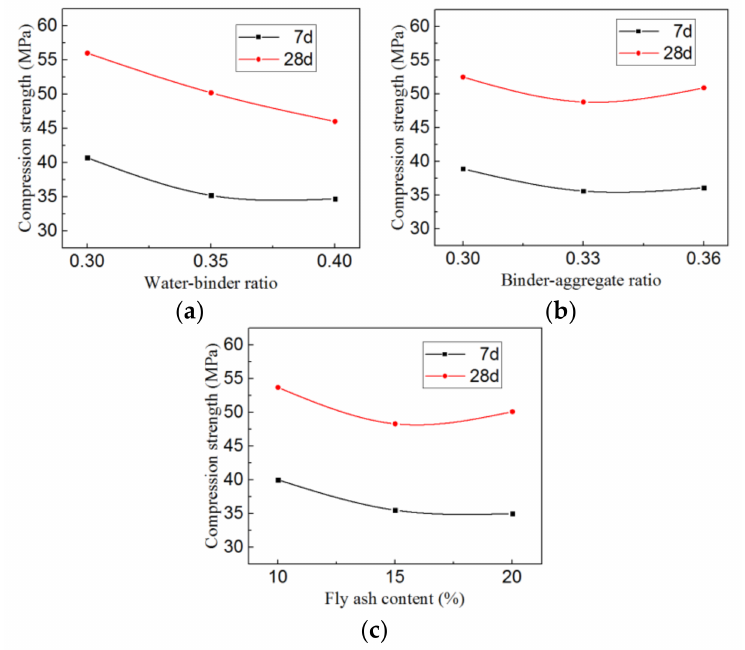
Figure 3. The relationships between the compressive strength and various levels of each factor ( a ) Water-binder ratio, ( b ) Binder-aggregate ratio, ( c ) Fly ash content.